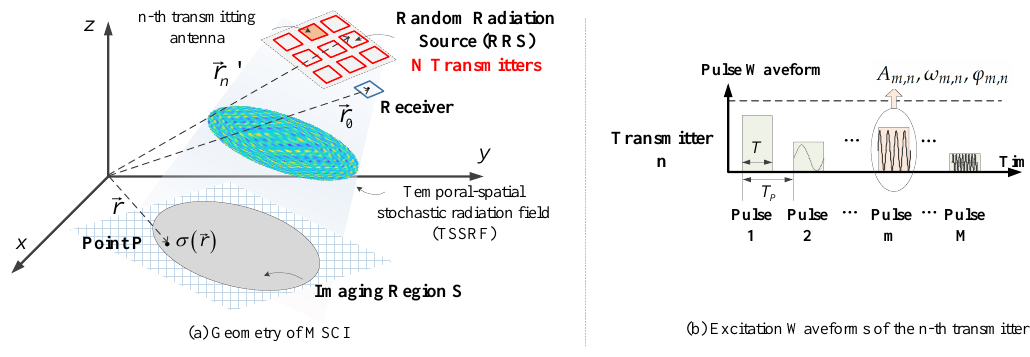
Figure 2. The geometry of MSCI and the excitation